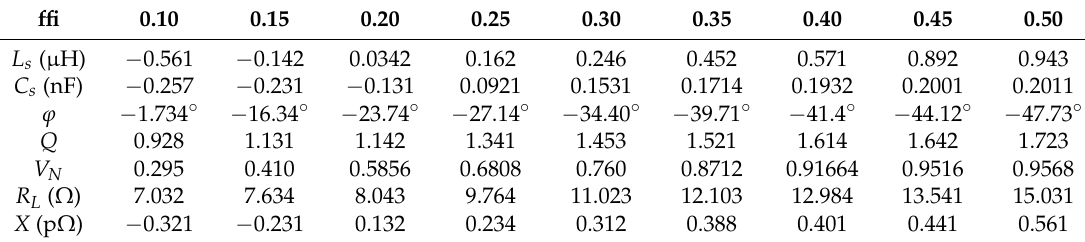
Table 1. Class E amplifier parameters for different duty ratio with CCWPT.